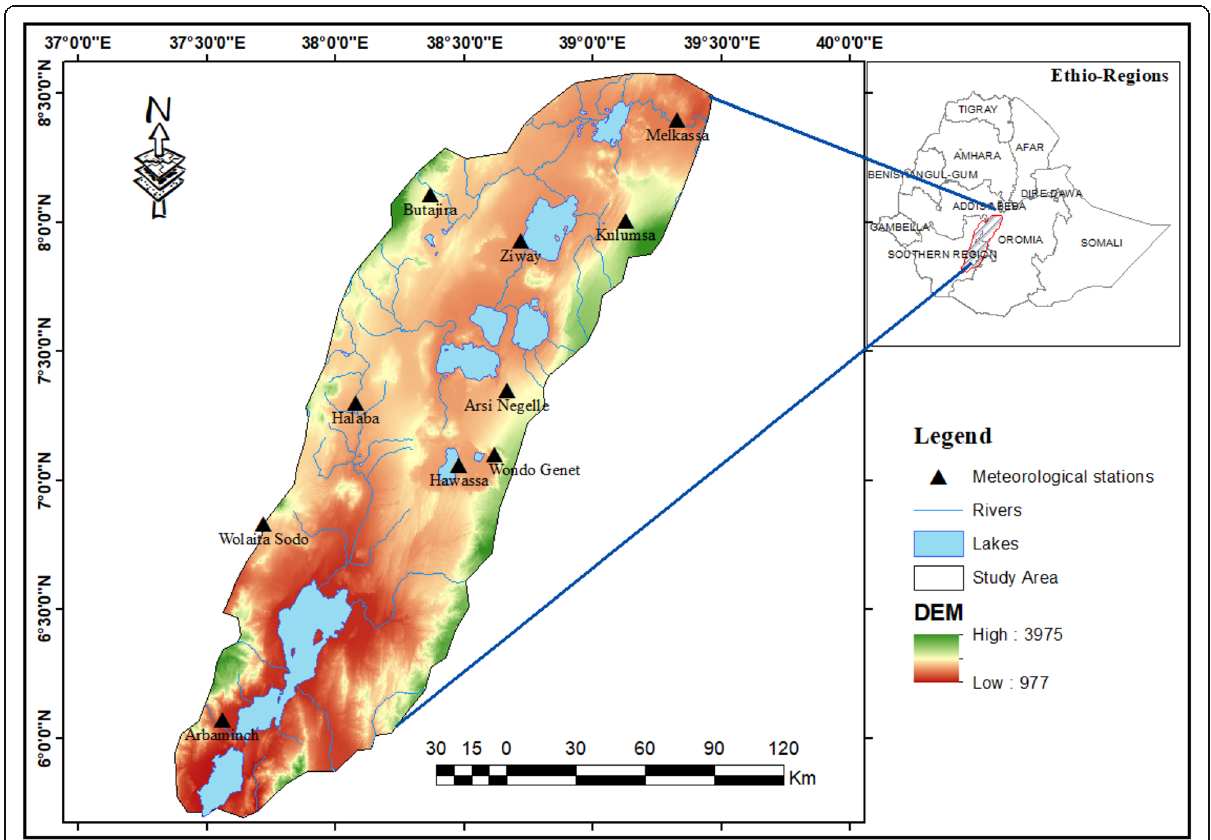
Fig. 1 Map of Lake Regions of ethiopian Rift